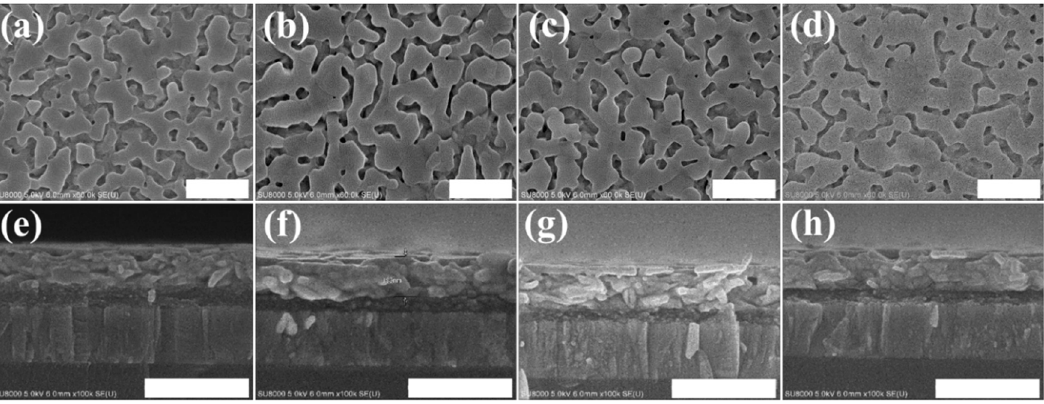
Figure 4. Plane and cross-section scanning electron microscope (SEM) images, respectively, of PbI 2 prepared with ( a , e ) 2% water, ( b , f ) 2% water + KI (4 mg / mL) ( c , g ) 2% water + KBr (1 mg / mL), and ( d , h ) 2% water + KCl (2 mg / mL). (Scale bar = 500 nm).